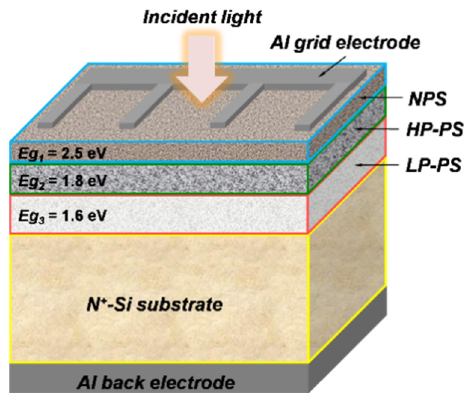
Figure 2. Schematic structure of the developed Si-based photovoltaic device with a triple-layered porous-Si (TLPS) structure as the light-absorption region.